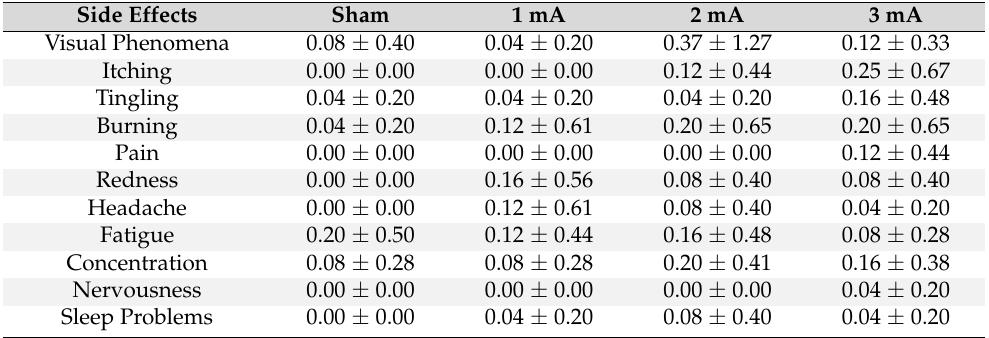
Table 4. Side effect ratings included visual phenomena, itching, tingling, and pain during stimulation, and skin redness, headache, fatigue, difficulty in concentration, nervousness, and sleep problems within 24 h after stimulation. The presence and intensity of side effects were rated on a numerical scale from zero (feeling nothing) to five (extremely strong feeling). Data are presented as mean ± SD.